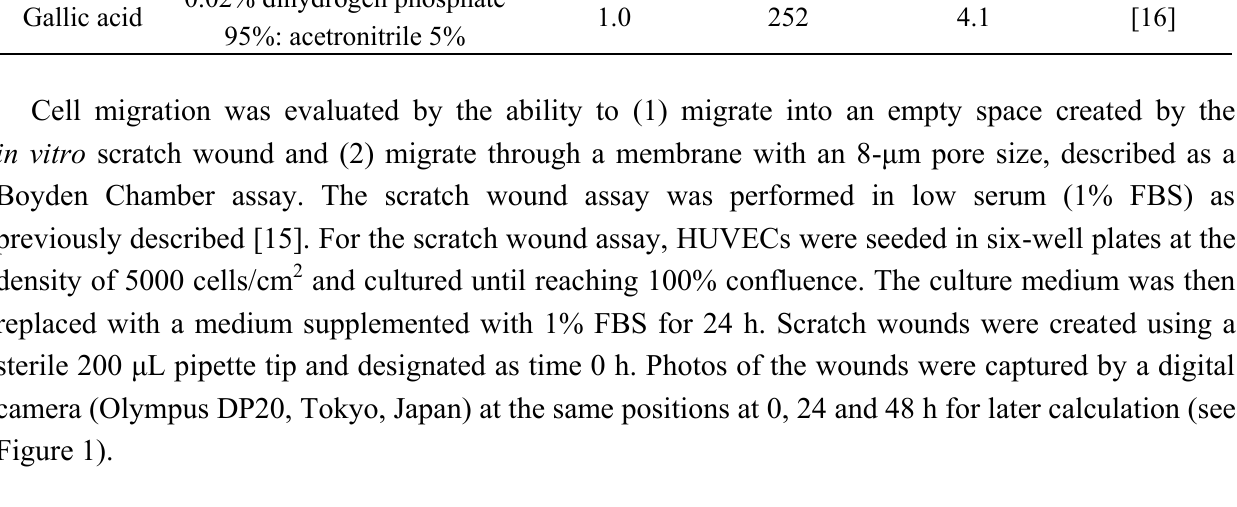
Figure 1. Calculation of percent wound confluence. A: the width of initial scratch wound, B: the width of scratch wound at time 24 or 48